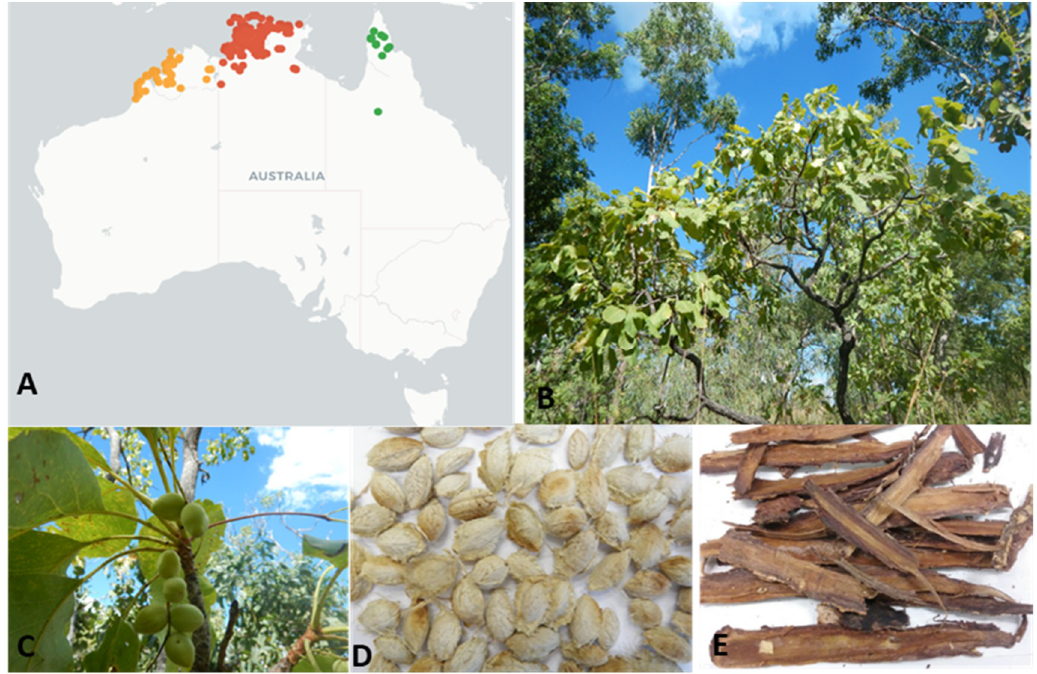
Figure 1. ( A ) Distribution of Terminalia ferdinandiana from the Australasian Virtual Herbarium website. (https: // avh.ala.org.au) showing (cid:8) West Australian, (cid:8) Northern Territory and (cid:8) Queensland locations. ( B ) Mature tree; ( C ) leaves and fruits; ( D ) seeds; and ( E )